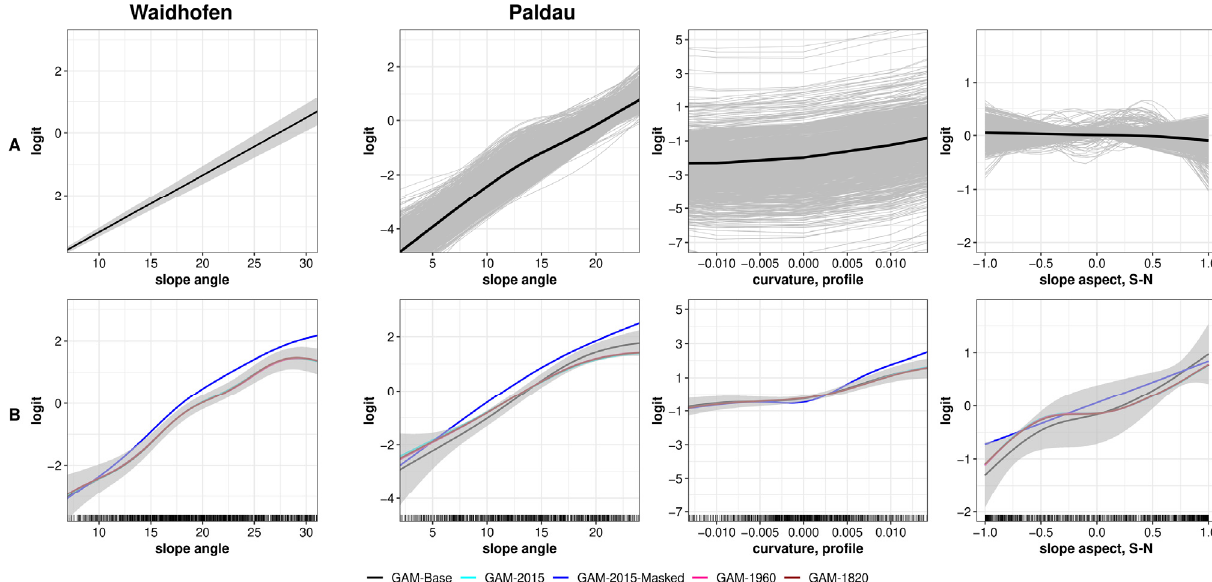
Figure 6. Comparison of predictor-response relationships between event-based landslide and historical LiDAR-derived landslide inventories. ( A ): Event-based inventory of Waidhofen (left, Table 1 in [74]) and southeast Styria (right, [73]). ( B ): Historical LiDAR-derived inventory of Waidhofen (left) and Paldau (right). Note: the logit scale is variable-dependent, the intercept for slope angle in Waidhofen was artificially set, and the x axes are limited to the 5th to 95th percentile range.